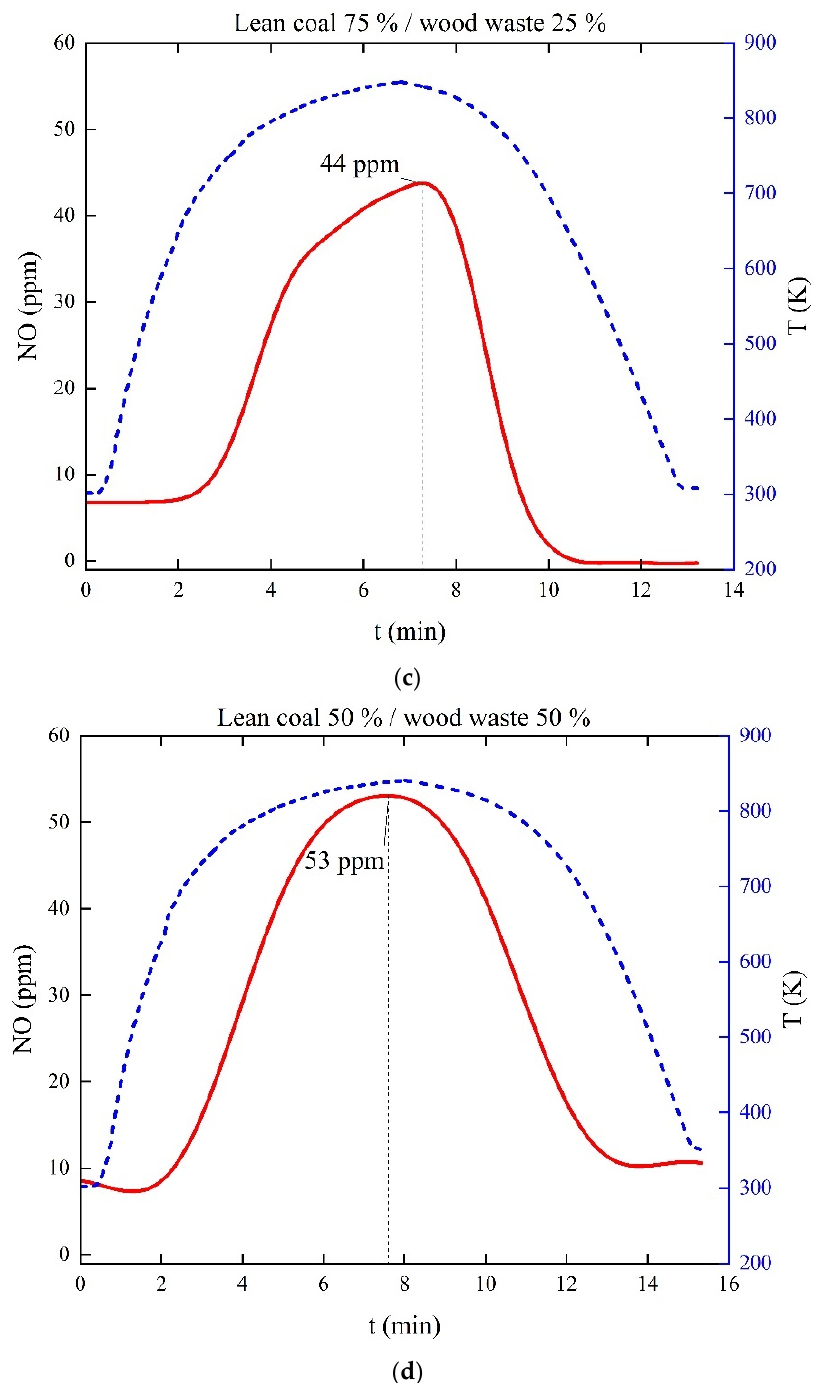
Figure 7. Changes in the concentration of nitrogen oxides in the gaseous products of the thermal decomposition of mixed fuels based on T-grade coal and wood with a change in the proportion of the latter in the mixture from 10% to 50%: ( a ) lean coal 100%; ( b ) lean coal 90%/wood waste 10%; ( c ) lean coal 75%/wood waste 25%; ( d ) lean coal 50%/wood waste 50%.